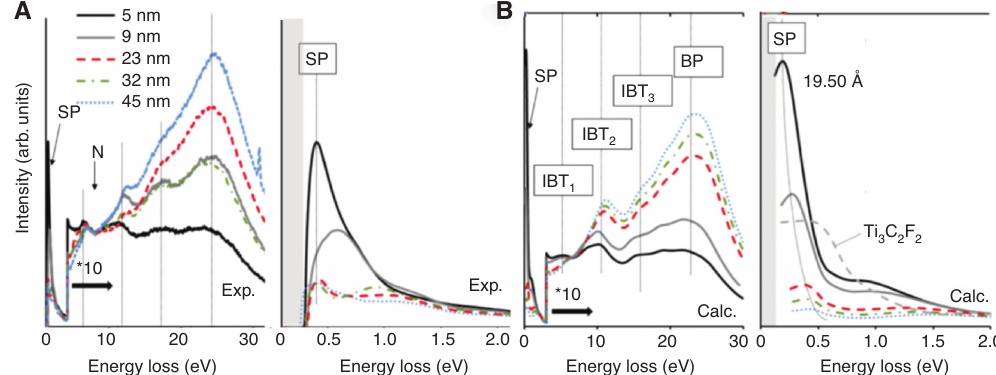
C T for different 3 2 2